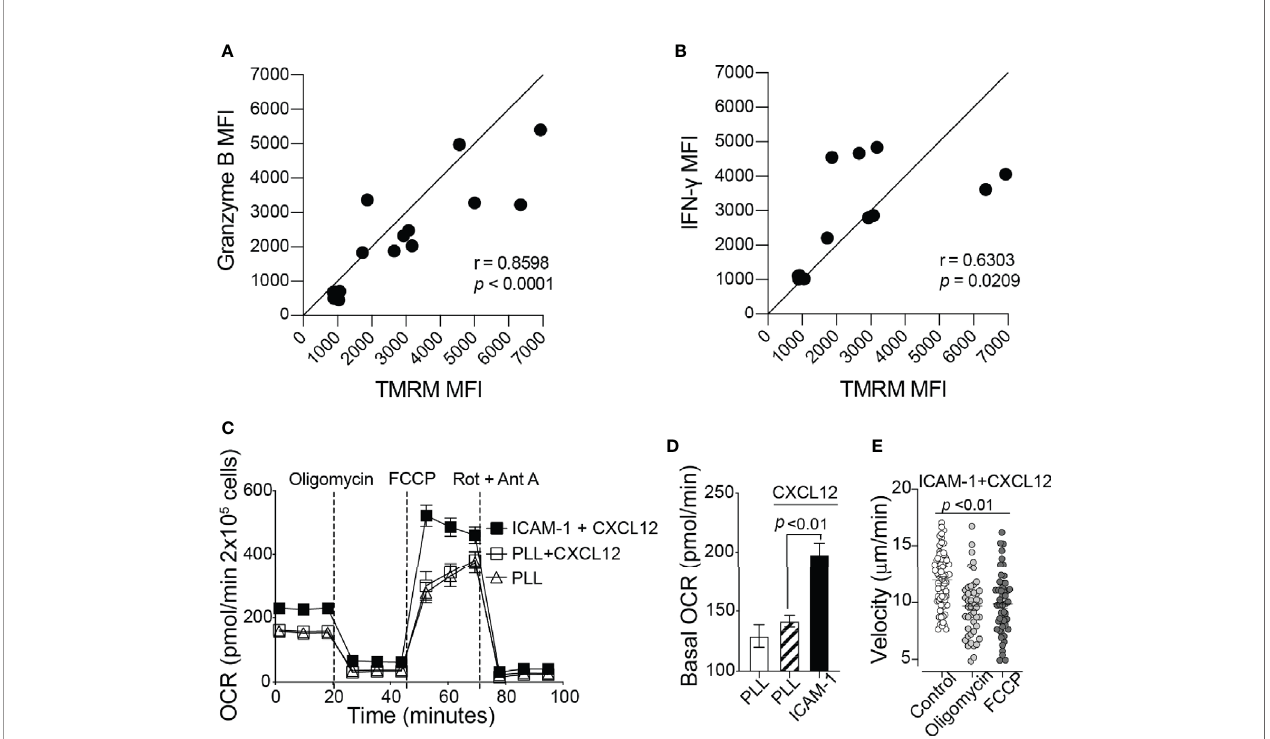
FIGURE 2 | Mitochondrial respiration is important for cytokine production and migration of CD8 + T cells. Flow cytometry MFI of (A) Granzyme B and (B) IFN- g production throughout mouse CD8 + T cell activation, shown as a function of TMRM MFI (n = 6 mice). (C) The complete OCR trace and (D) the basal OCR measured with the Seahorse MitoStress Test, of activated CD8 + T cells on Poly-L-lysine ± CXCL12, or migrating on ICAM-1 with CXCL12 (Representative of three independent experiments). (E) The velocity of activated CD8 + T cells migrating on ICAM-1 + CXCL12. Treated cells (2 µM oligomycin or 2 µM FCCP) were incubated with the drug for 20 minutes before the start of the 20-minute movie (Representative of three experiments). Migration data analyzed with Volocity software. (A, B) Pearson ’ s correlation. (D, E) Data shown as mean ± SEM and analyzed by one-way ANOVA with a Bonferroni